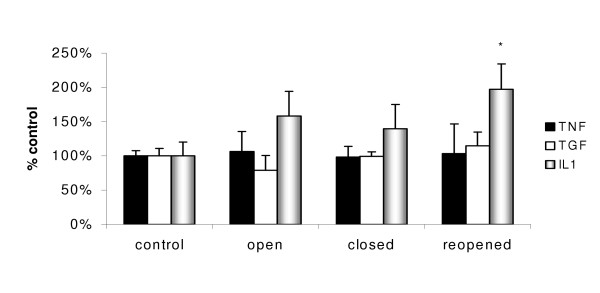
The mRNA expression by rat bronchoalveolar lavage cells 18 hr following instillation of aqueous extracts of PM10 collected before, during and after the steel plant closure (* p < 0.05 to control). Values represent the mean of 6 rats ± SEM.